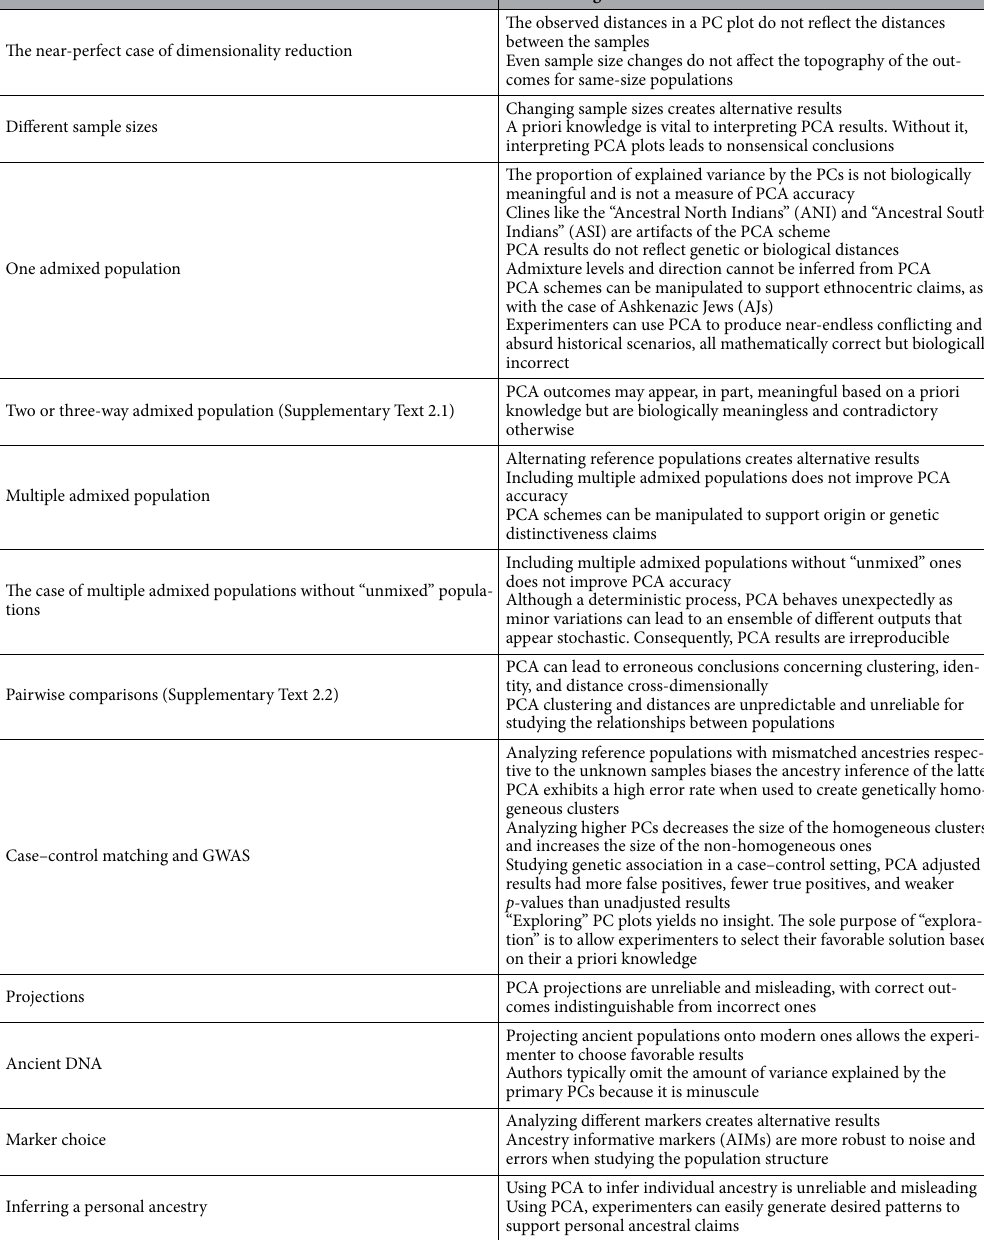
Table 1. A summary of the main findings of the twelve test cases studied